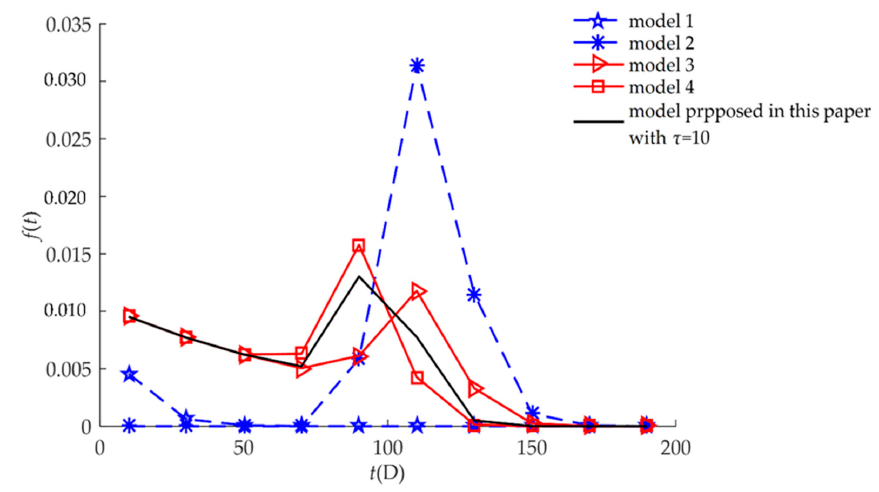
Figure 9. Comparison of f ( t ) for different models for example II.